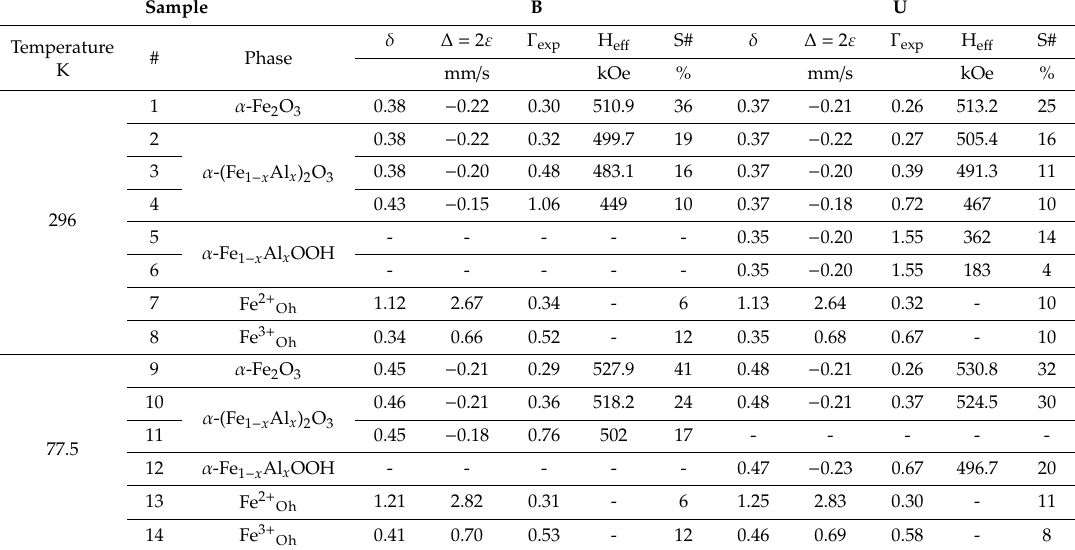
Figure 3. Mössbauer spectra obtained at 296 K ( a , c ) and 77.5 K ( b , d ) of the red mud samples U ( a , b ) and B ( c , d ) and their model description with numbering of subspectra according to Table 2. Table 2. Mössbauer spectra parameters and iron phase distribution in the red mud samples B and U, where δ —chemical shift; ∆ = 2 ε —quadrupole splitting; Γ exp —line width; H e ff —hyperfine magnetic field; S—site #